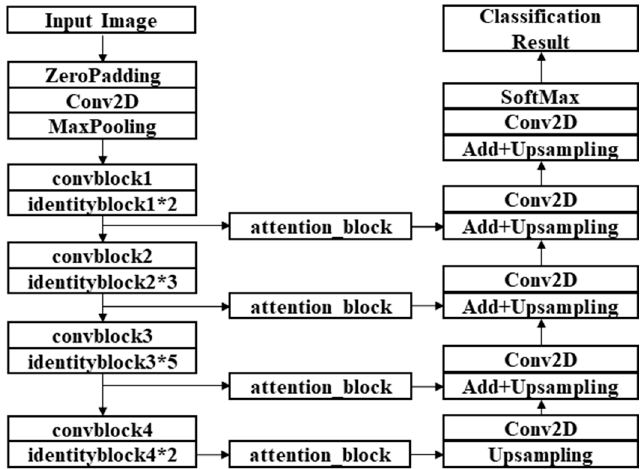
Figure 4. Structure of ResMANet (residual multi-attention network).